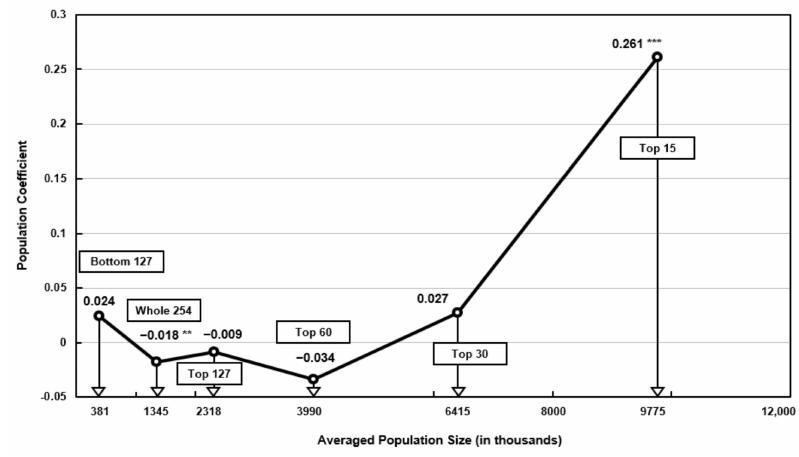
Figure 3. Distribution of population size coefficients and averaged population size for all cities and the five subgroups of cities (2001–2013). *** p < 0.01, ** p <